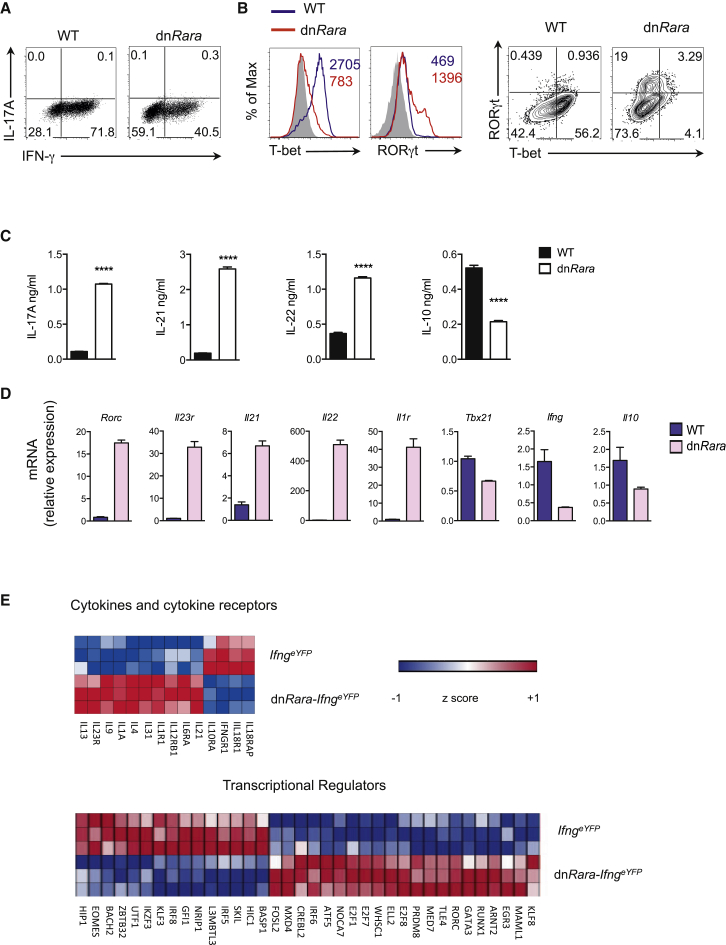
RA Signaling Required for Th1-Cell Differentiation and Repression of Th17-cell Fate in Th1-Cell PrecursorsSorted naive CD4+ T cells from dnRara or WT mice were cultured under Th1 conditions for 6 days.(A) Intracellular expression of IFN-γ and IL-17A following stimulation with PMA and ionomycin.(B) T-bet and RORγt expression. Grey histograms indicate staining for Tbx21–/– (left panel) or isotype control antibody (right panel). Numbers show MFI. Numbers in quadrants represent percent cells in each.C) Amount of IL-17A, IL-21, IL-22, and IL-10 in supernatants following restimulation of cells as in (A) with α-CD3 and α-CD28 for 24 hr as measured by multiplex bead array. Triplicate culture wells.(D) Quantitative real time PCR analysis of Th1 and Th17-cell signature cytokine and TF genes following stimulation with PMA and ionomycin.(E) Naive CD4+ T cells from dnRara-IfngeYFP and IfngeYFP mice were cultured under Th1 conditions. IFN-γ (eYFP+) cells were sorted on day 7 following stimulation with PMA and ionomycin. Heatmaps displaying the fold changes of genes that were differentially expressed (fold change > 1.5, p < 0.05) for selected cytokines or cytokine receptors (upper panel) and TFs (lower panel). Samples from three independent experiments.Representative data of at least three (A and B) or two (C and D) independent experiments. Mean ± SEM.See also Figure S2.